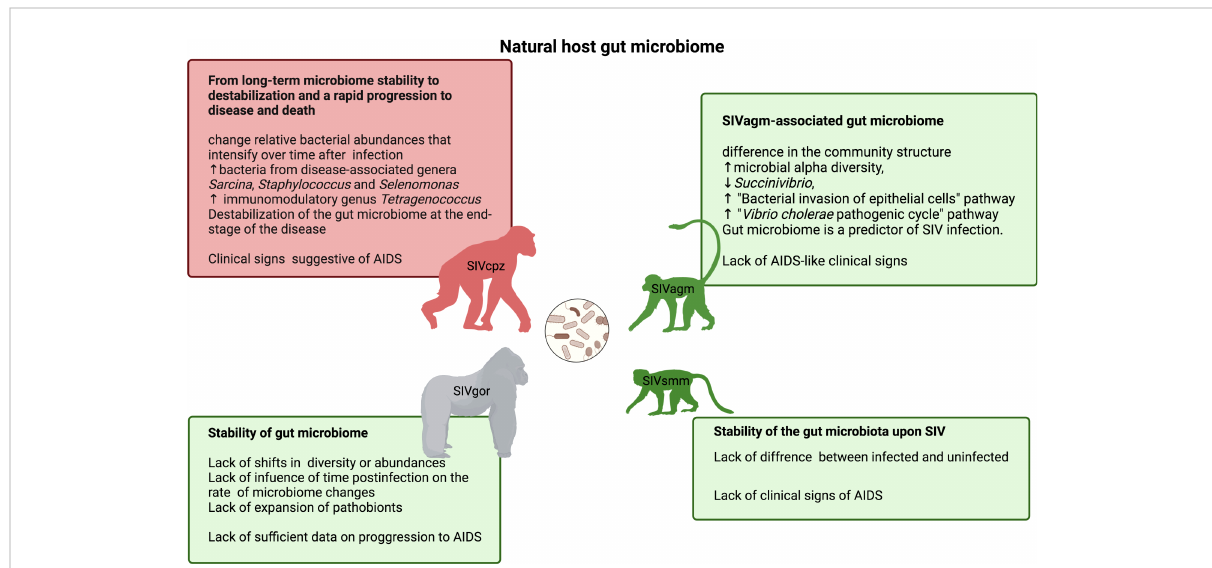
FIGURE 3 The gut microbiome of natural NHP hosts of SIV infection: chimpanzee, a host displaying mixed clinical signs of progressing and non- progressing SIV infection (top left) (164, 165); gorilla, a host with lacking suf fi cient data on clinical indicators of AIDS (bottom left) (166); and hosts that typically do not develop immunode fi ciency and simian AIDS - vervet/AGM (top right) (92) and sooty mangabey (bottom right)